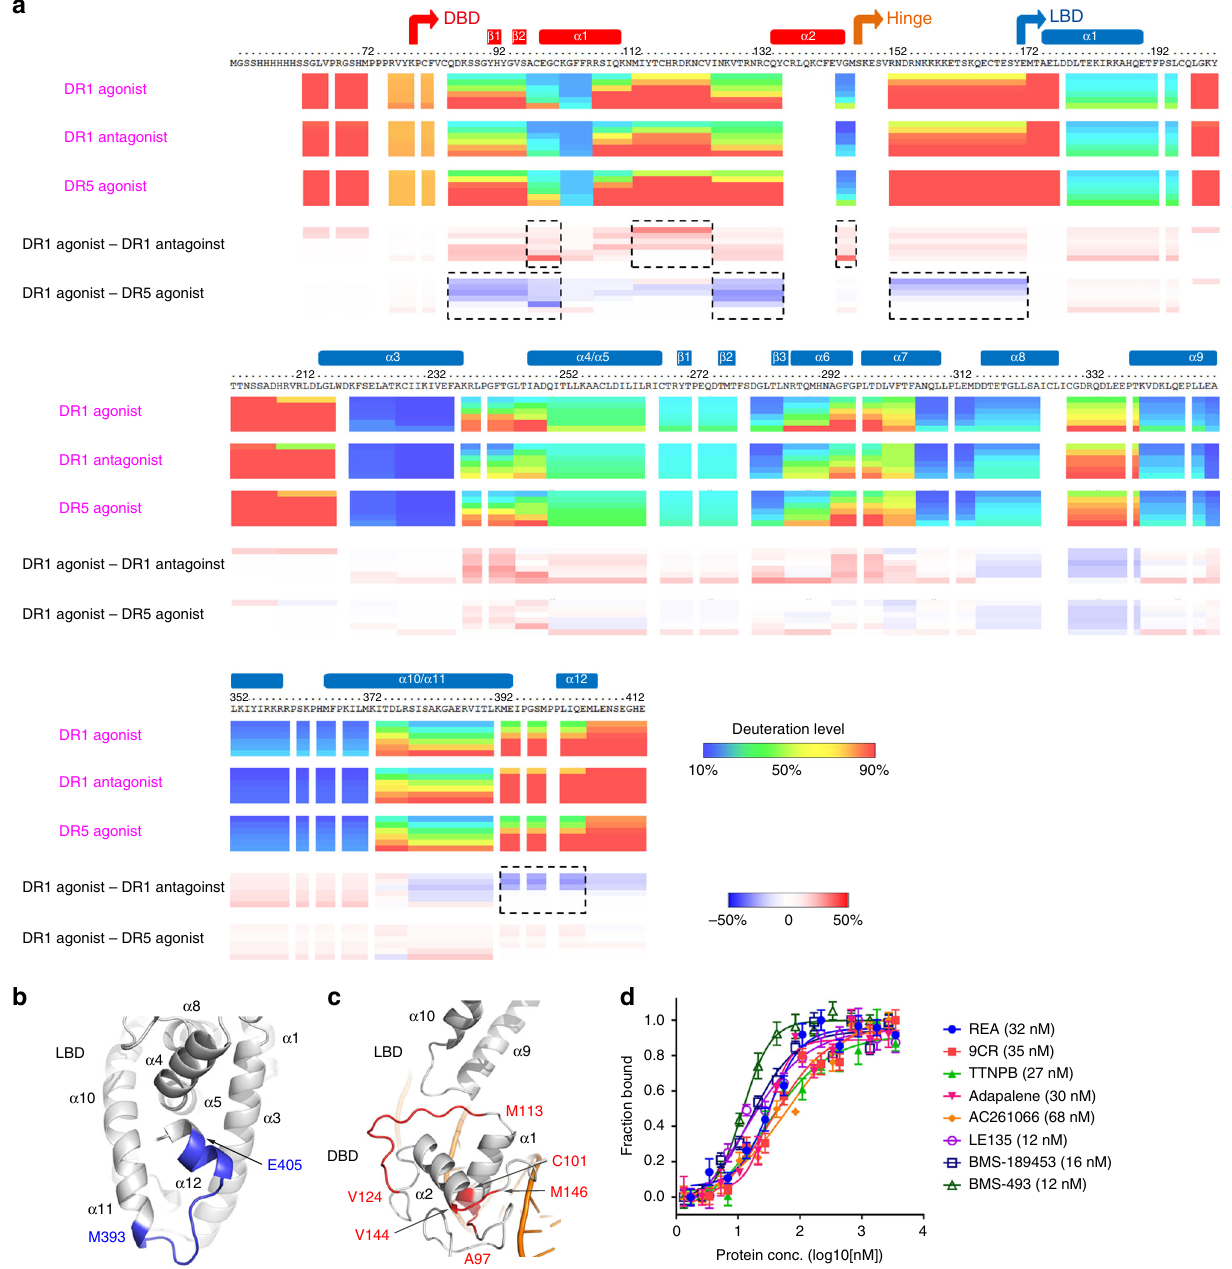
Fig. 2 Dynamic features of RAR β protein in the RAR β – RXR α heterodimer measured by H/D-ex MS and effects of different ligands on DNA binding. a The three ribbon maps showing the deuteration level of RAR β residues are from states in the presence of DR1 DNA and agonist REA (1st row), DR1 DNA and antagonist BMS-189453 (2nd row), DR5 DNA and agonist REA (3rd row), respectively. The 4th row shows the differences between 1st and 2nd rows (i.e., DR1 agonist minus DR1 antagonist), while the 5th shows those between 1st and 3rd (i.e., DR1 agonist minus DR5 agonist). The regions with relative larger differences are boxed by dotted lines. For each map, there were six time points (30, 100, 300, 1000, 3000, and 10,000 s, from top to bottom). The domain ranges and secondary structures are labeled above the protein sequence. b , c Regions in RAR β LBD ( b ) and DBD ( c ) displaying more (red) or less (blue) dynamics in the hydrogen/deuterium exchange, when comparing the data from DR1 and agonist (REA) to those from DR1 and antagonist (BMS-189453) (i.e., corresponding to the 4th row in Fig. 2a). The secondary structures and residue ranges are labeled accordingly. d DNA-binding af fi nities of RAR β – RXR α heterodimer to DR1 DNA measured in the presence of different ligands. REA, 9CR, TTNPB, adapalene, and AC261066 are agonists for RAR β ; while LE135 and BMS-189453 are antagonists, and BMS-493 is an inverse agonist for RAR β . K D values are in parentheses. The heterodimer protein was incubated with each ligand at 8× concentrations for 1 h before assays started. The data points are plotted as mean ± SD from three technical replicates